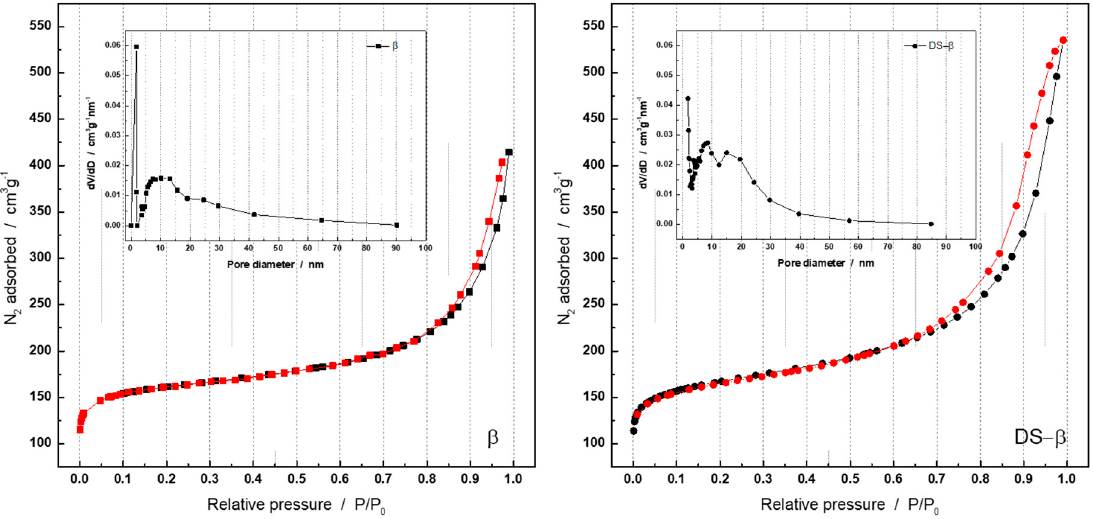
Figure 1. N 2 physisorption isotherms of β and DS- β .